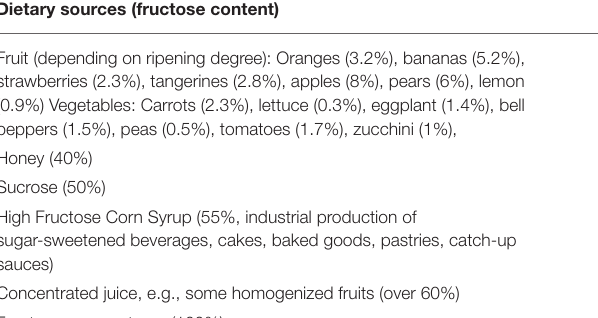
TABLE 1 | Dietary sources and endogenous production of fructose. Dietary sources (fructose